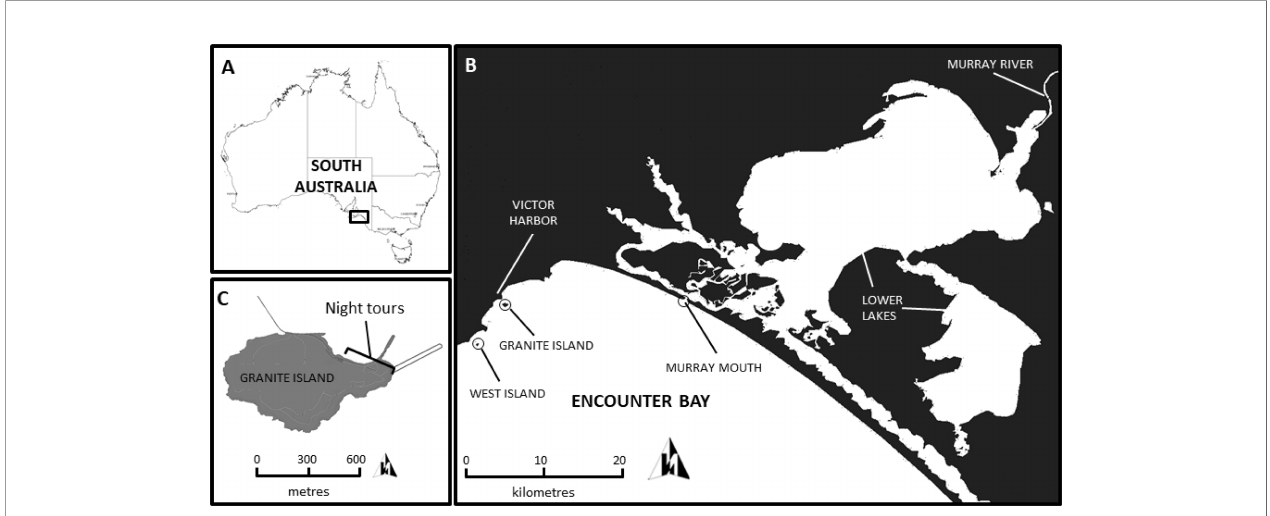
FIGURE 1 | Mapsofthe location of (A) the study area inAustralia, (B) Granite Island inrelation to the Murray River and West Island and (C) the night tours on Granite